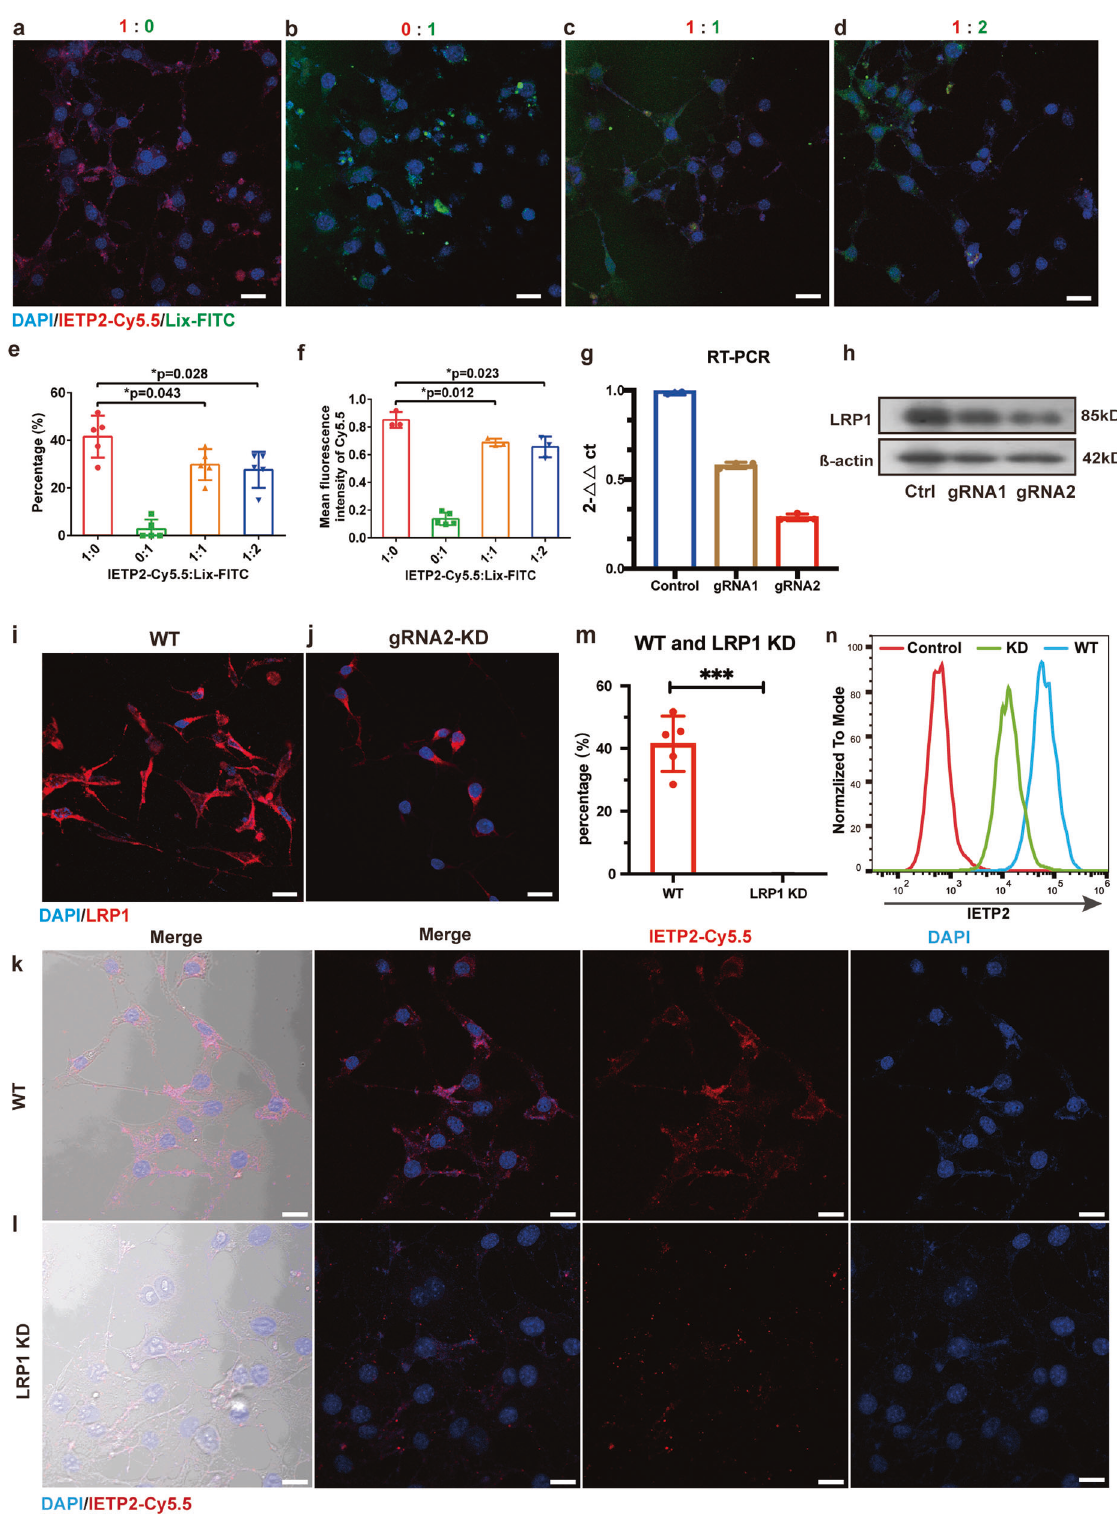
Fig. 3 LRP1 is responsible for the endocytosis of IETP2. a – d Microscopy images showing the competing endocytosis of IETP2-Cy5.5 and Lix- FITC by HEI-OC1 cells. The endocytosis of IETP2-Cy5.5 was partially reduced by Lix-FITC. e - f Quantitative analysis of the fl uorescence intensity in a – d . e Quantitative data showing the percentages of IETP2-Cy5.5-positive cells. f Quantitative data showing the mean intensity of IETP2- Cy5.5 in cells. g RT – PCR showing the knockdown (KD) ef fi ciency of Lrp1 with two different gRNAs. h Western blot showing the expression of LRP1 after LRP1 knockdown with two different gRNAs. i , j Immuno fl uorescence images showing the expression of LRP1 in WT and LRP1-KD HEI-OC1 cells. k , l Microscopy images showing the endocytosis of IETP2 in WT or LRP1-KD HIE-OC1 cells. Greatly reduced endocytosis of IETP2 in LRP1-KD HEI-OC1 cells was observed. m Quantitative analysis of the images in k , l . n Flow cytometry showing the reduced endocytosis of IETP2 in LRP1-KD HEI-OC1 cells. Error bars represent the mean ± SD. N = 5 for e , f , m . N = 3 for g . * p < 0.05, *** p < 0.001. Scale bars: 20 µm Signal Transduction and Targeted Therapy (2022)